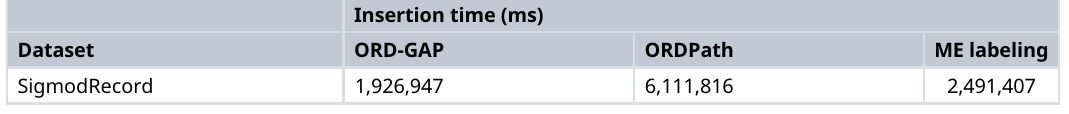
Table 5. XML data insertion on DBLP dataset.